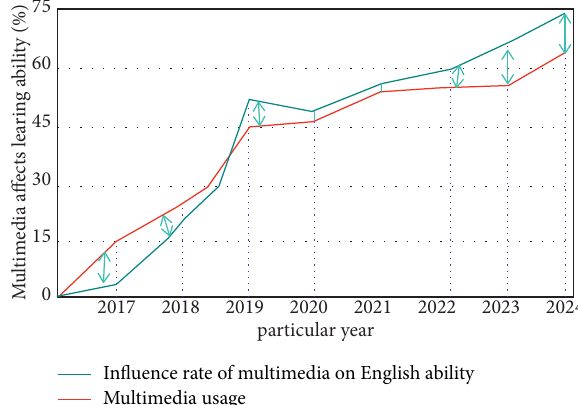
Figure 10: Influence of multimedia on learning and multimedia application rate